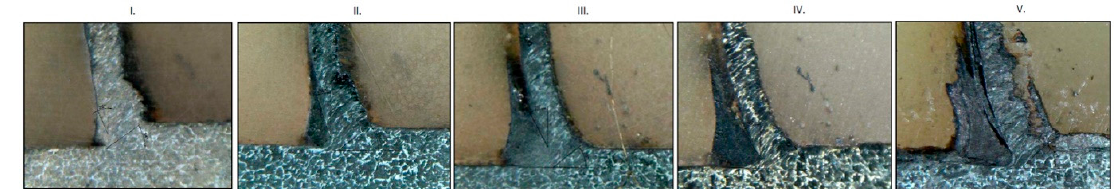
Figure 10. Successive chip roots (magnified 200×) of carbon steel EN C45 at orthogonal cutting with the parameters v c = 15 m·min − 1 , a p = 0.2 mm, γ = 8°, and λ s = 0°. the parameters v c = 15 m · min